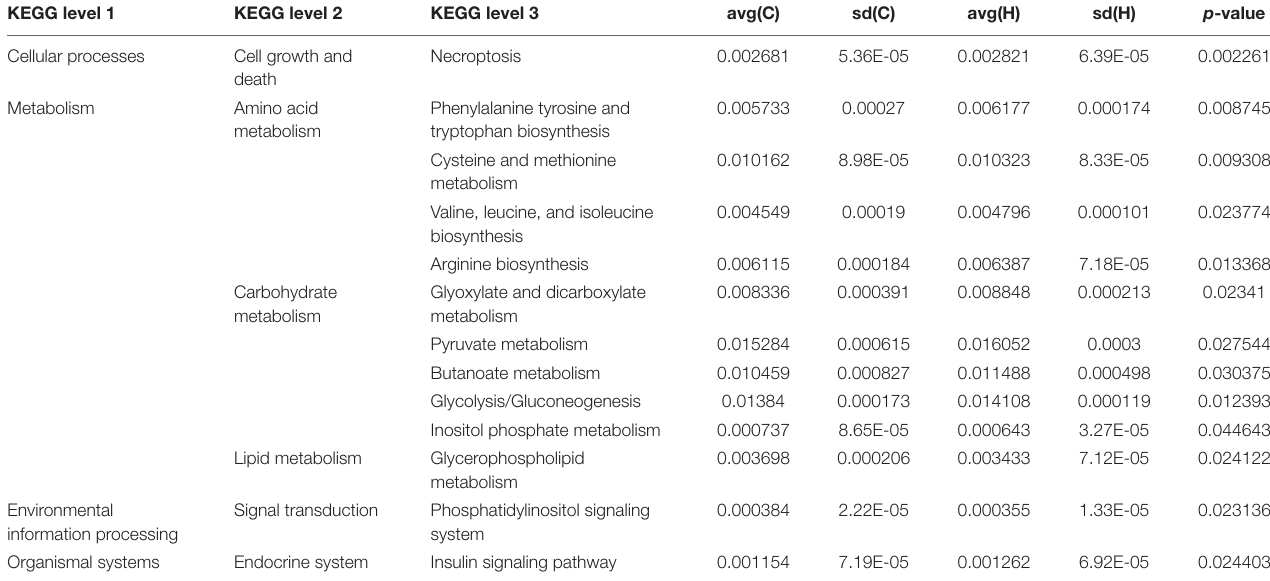
TABLE 4 | KEGG pathway affected by heat stress in rabbits.